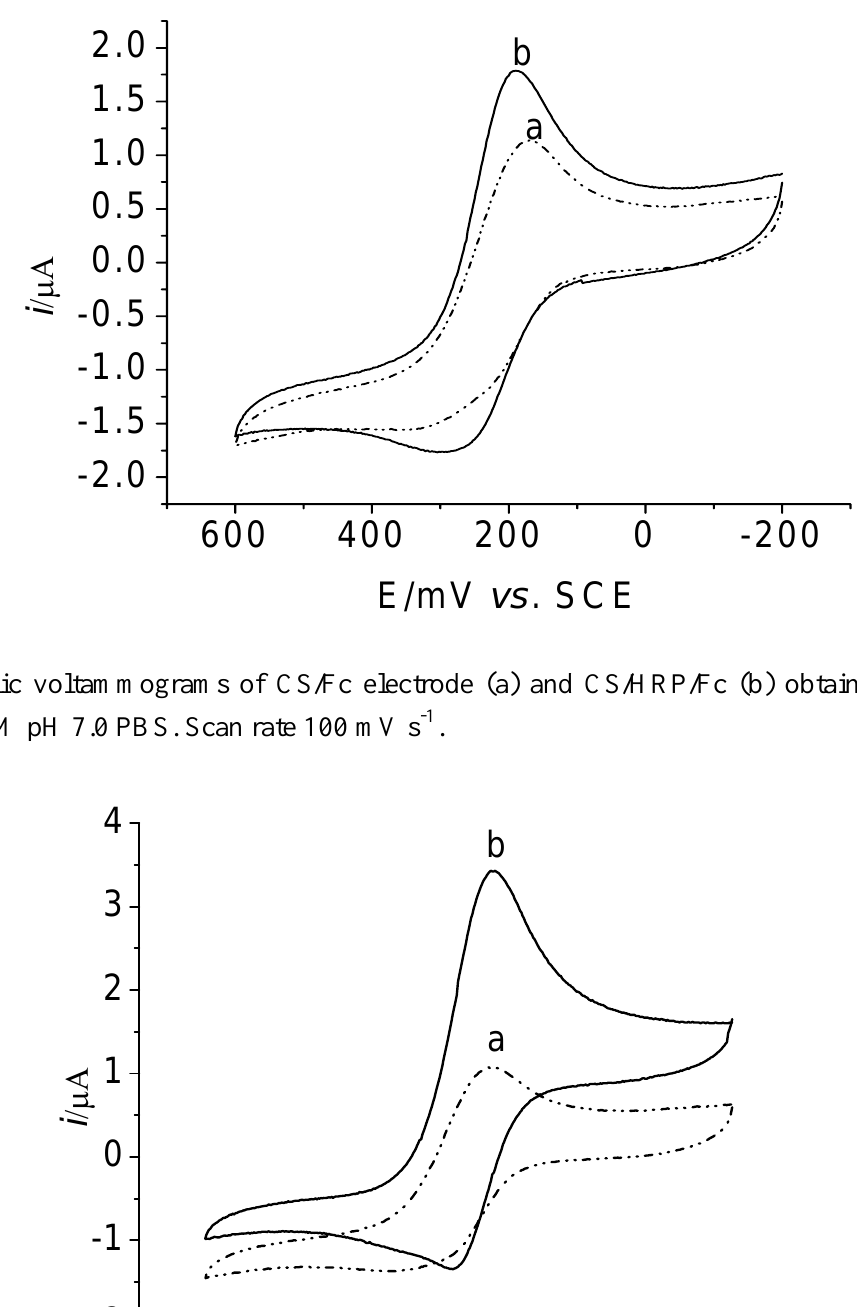
O . Scan rate 100 mV s -1 2 2